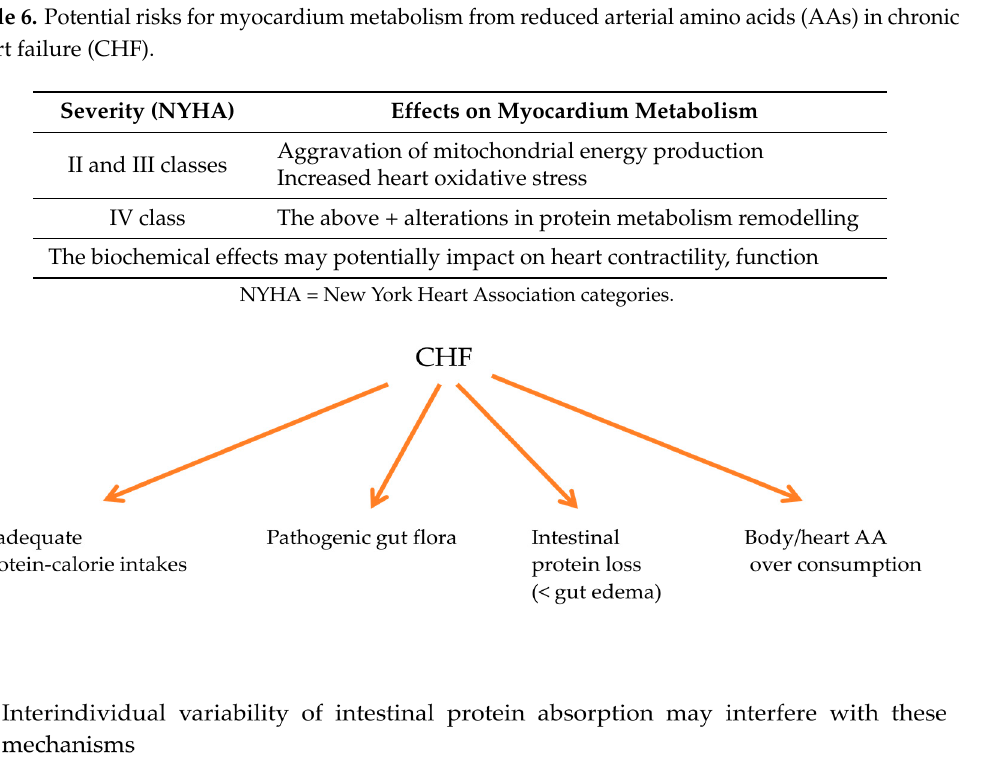
Figure 3. Synthesis of mechanisms for reduced arterial amino acids levels in clinically stable chronic heart failure (CHF).